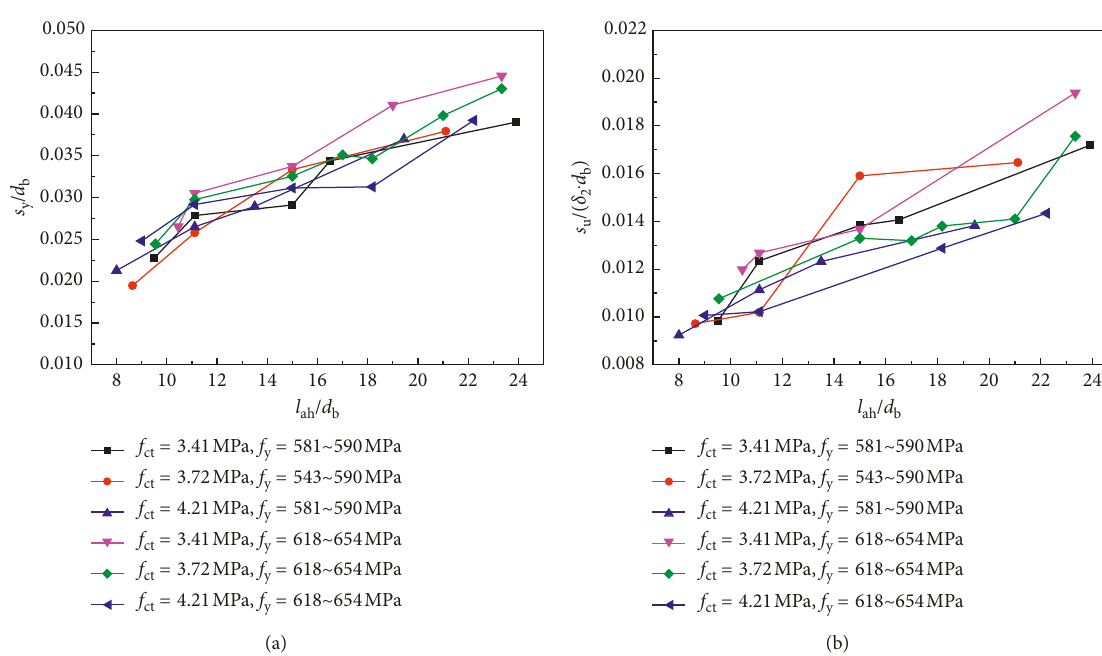
Figure 20: Effect of l ah /d b on (a) s y and (b) s u / δ 2